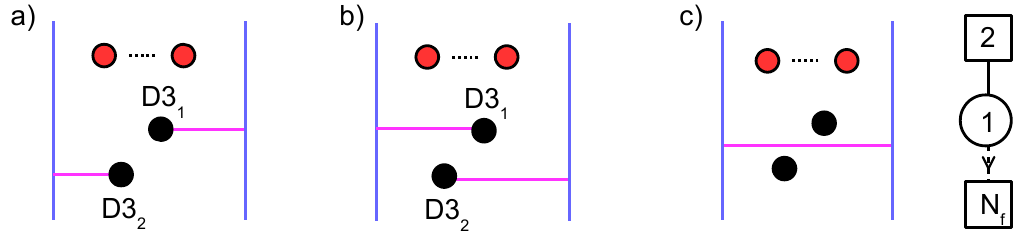
Figure 4 . The three con(cid:12)gurations contributing to V supporting our proposal for the brane realisation of monopoles. In principle, we have all the ingredients to write down the exact VEVs of monopole operators in the U(2) SQCD